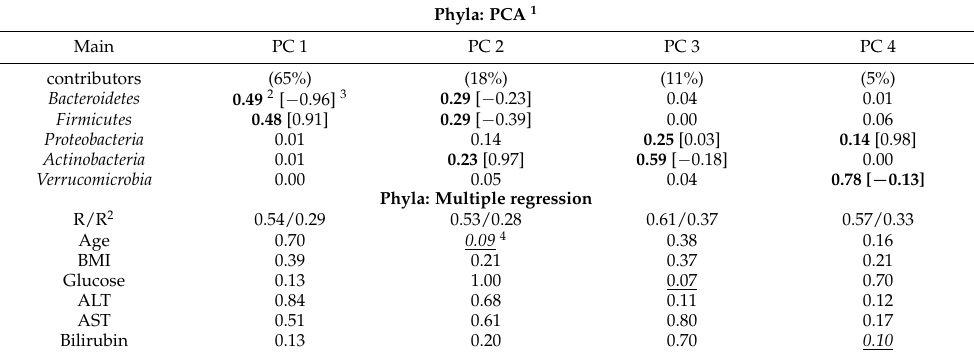
Table 2. Statistical analyses’ results: contribution of bacterial phyla to the principal components ex- tracted from the matrix with relative abundance in feces of females with GSD before CCE (percentage of the total data variance in brackets) and p -values for multiple regression with age, BMI and blood